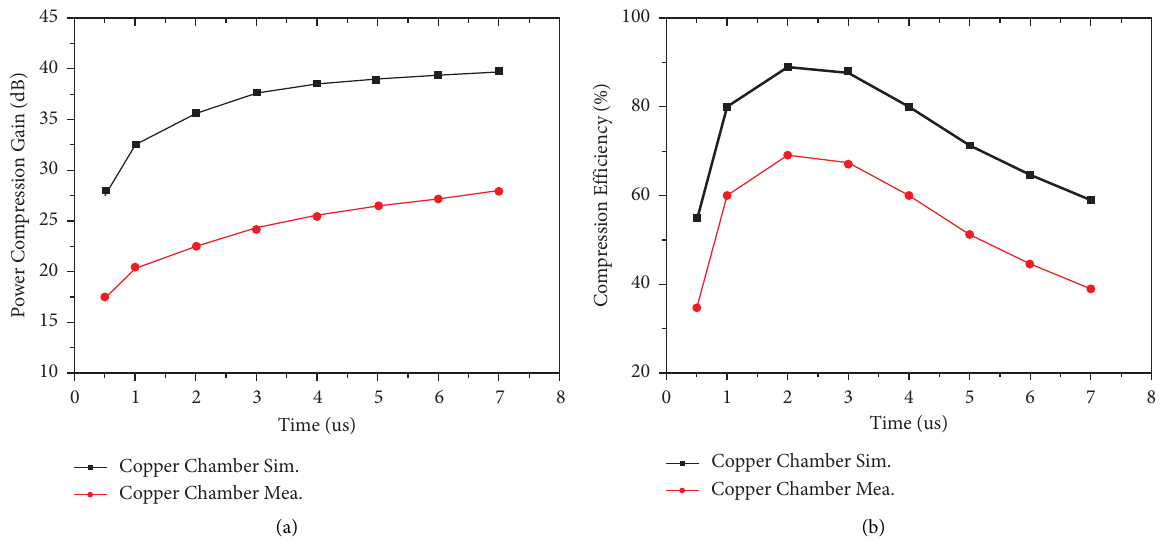
Figure 9: Comparison of measured and simulated pulse compression performance along with the time length of input pulse for the rectangular reverberation chamber with copper material. (a) Comparison of the measured and simulated PCG along with the time length of input pulse for rectangular reverberation chamber with copper material. (b) Comparison of the measured and simulated CE along with the time length of input pulse for rectangular reverberation chamber with copper material.